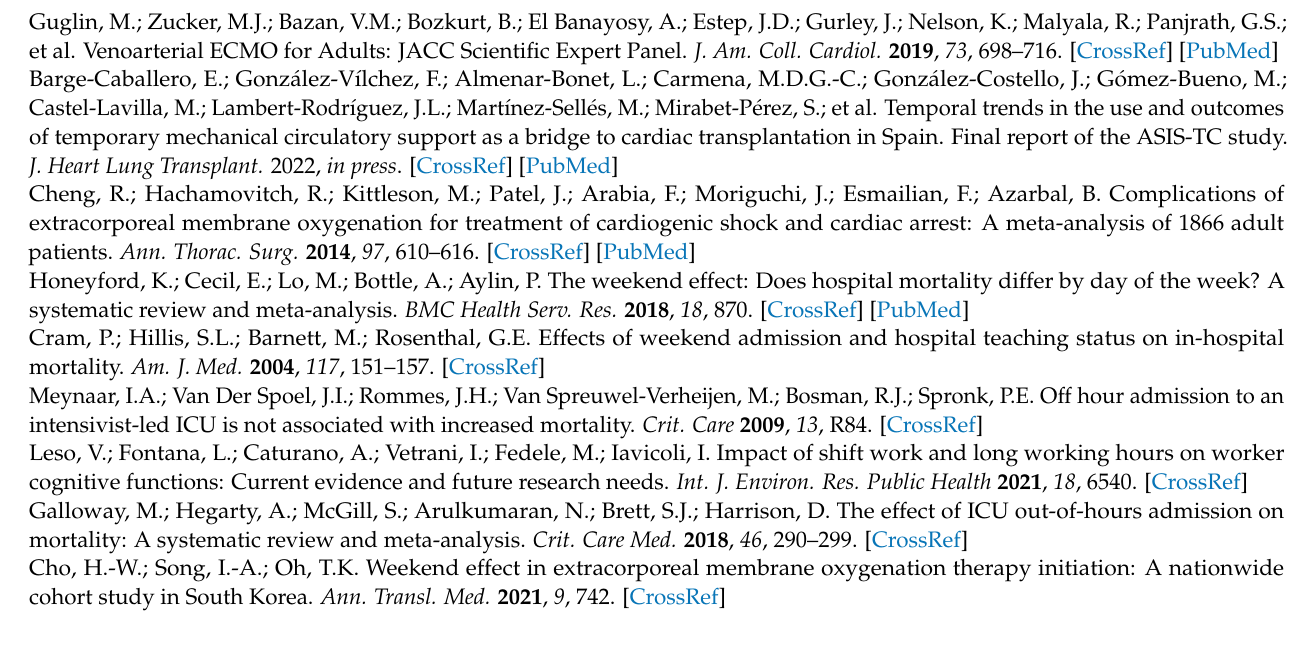
indications. Table S2: In-hospital mortality rates according to the use and type of left ventricle unloading device. Figure S1: Number of venoarterial extracorporeal membrane oxygenation implants made each year. Figure S2: Implant time and decision-implant time according to year of